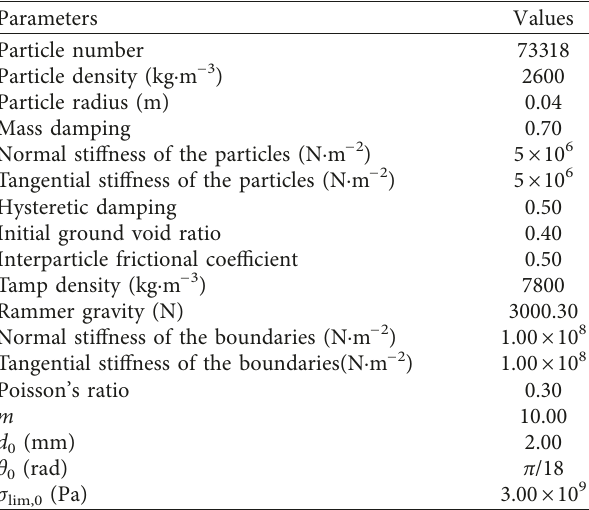
Figure 2: Discrete element model of dynamic Table 1: Microscale parameters of PFC 3D model.